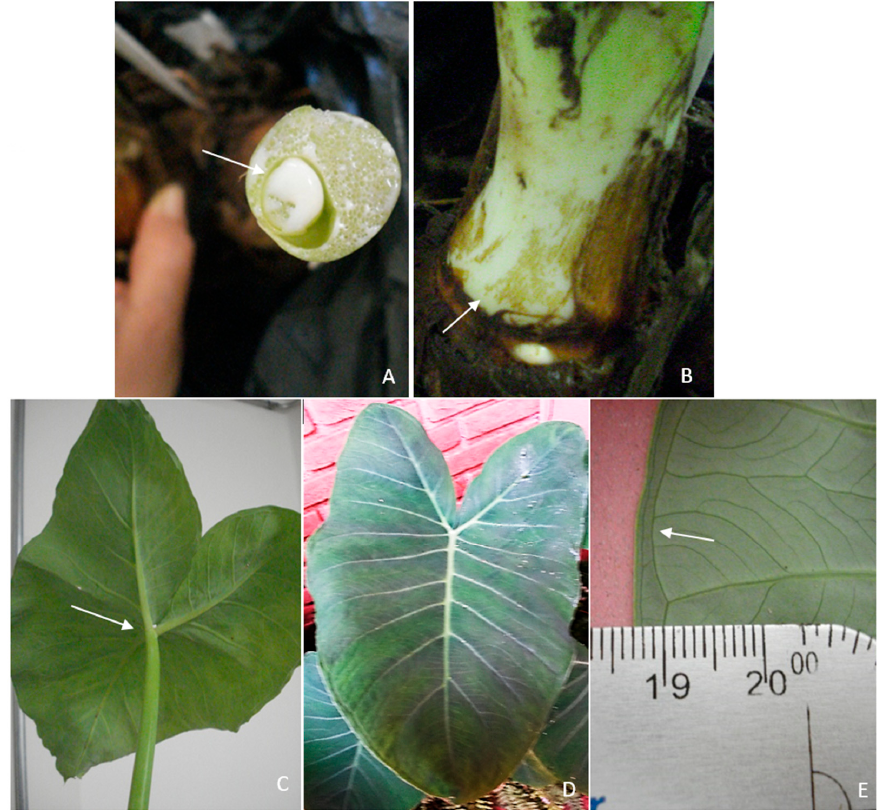
Figure 2. Images of X. sagittifolium . ( A ) The white color of exudate in stem (arrow); ( B ) The green color of the pseudostem (arrow); ( C ) The basal insertion of the petiole in leaf (arrow); ( D ) The upper leaf and its sagittate form; ( E ) The two collecting veins at the leaf margin (arrow) (Source: Laboratory of Plant Genetics/University of São Paulo, Campus of Ribeirão Preto, Brazil).